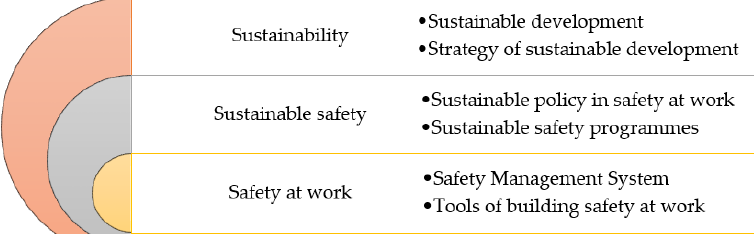
Figure 7. General levels of framework for sustainable safety in an enterprise.